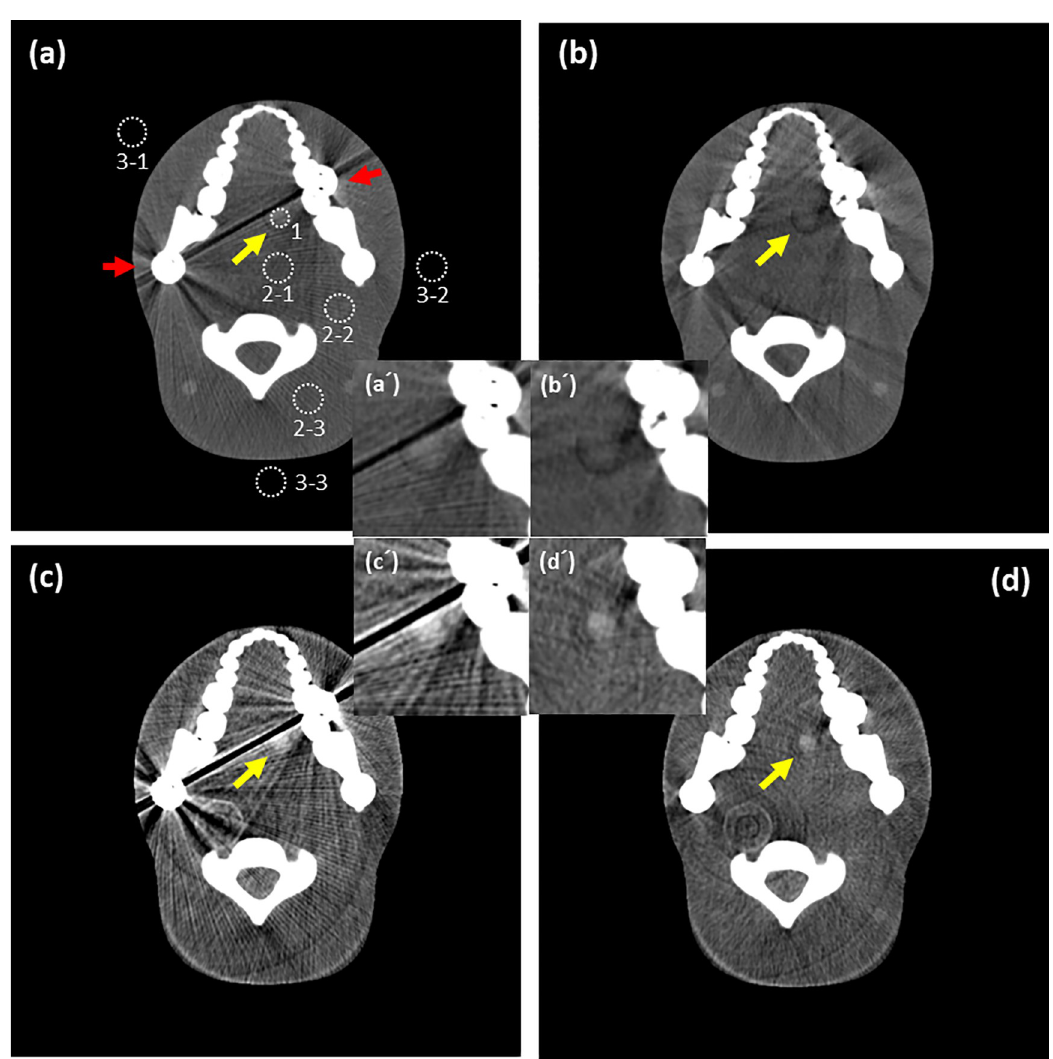
Fig 8. (a) Imaging of adult male ATOM phantom acquired at an energy level of 30 to 140 keV. White dotted lines outline the ROIs placed for objective image analysis: ROI1, area of iodine-enhanced tissue; ROI2s, normal tissue (area where metal artifact is less affected), and ROI3s surrounding air for measuring background noise. (b) Image with NMAR method applied to image A. (c) Virtual monochromatic image of 40 keV with MD applied to bin 1, bin 2, and bin 3 without NMAR. (d) Iodine-enhanced virtual monochromatic image (yellow arrow) at 40 keV, which applied NMAR and MD to bin 1, bin 2, and bin 3. The imaging shows how metal artifacts were removed and iodine was enhanced. (a´), (b´), (c´), and (d´) are magnified images of (a), (b), (c), and (d) focusing on the iodine-enhanced tissue. Display window: W/L = 600/150